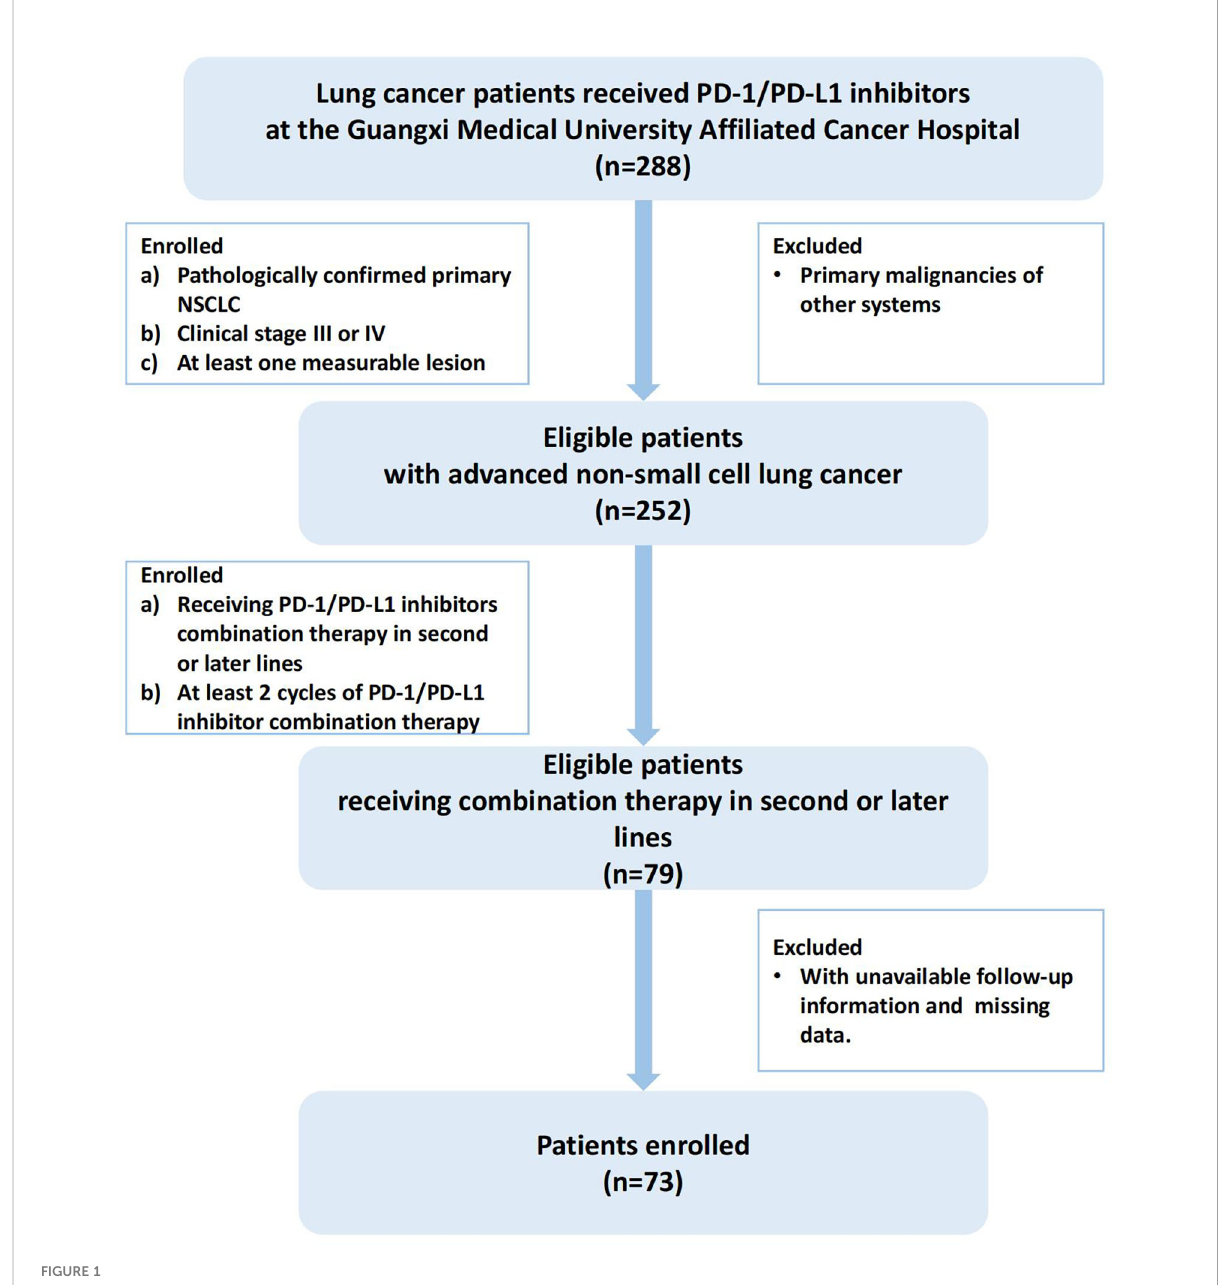
FIGURE 1 Flowchart of the